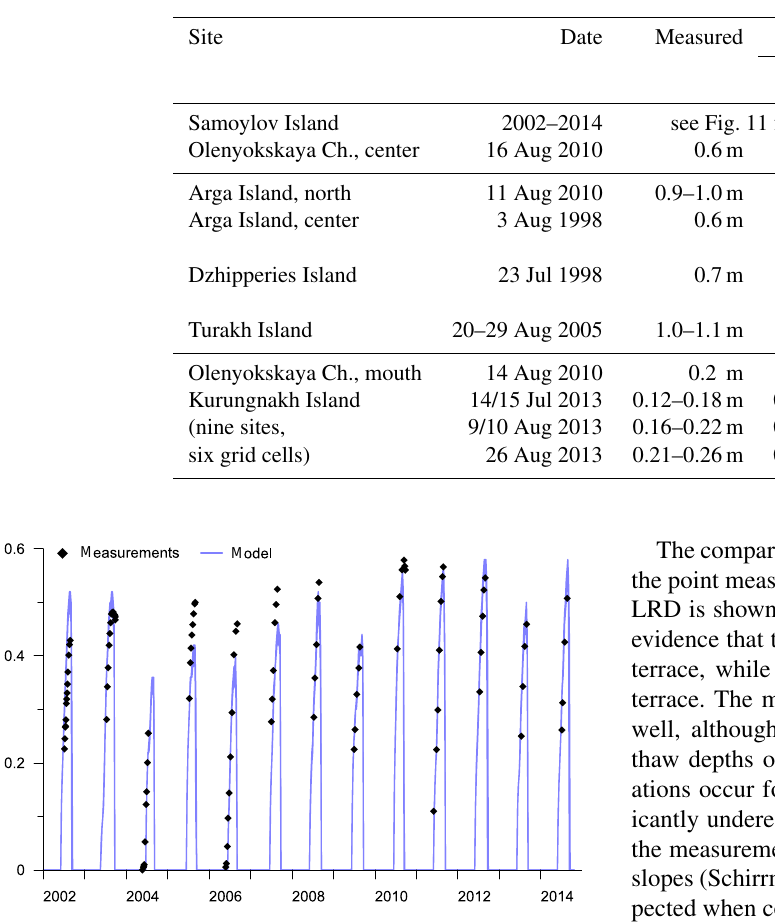
Figure 11. Modeled and measured thaw depths on Samoylov Island. The measurements correspond to the average of 150 locations on Samoylov Island (Boike et al., 2013). The average standard devia- tion of the measurements (i.e., the spatial variability of thaw depths) is 0.06m. The blue area depicts the spread between model runs with snow densities of 200 and 250kgm − 3